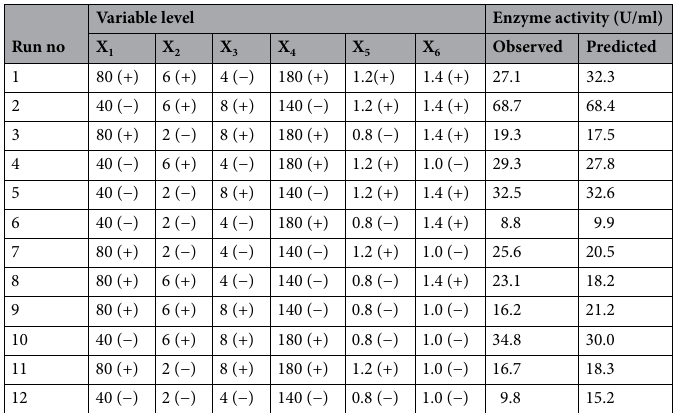
Table 2. Plackett–Burman design matrix for screening of six medium components for xylanase production by the Trichoderma harzianum strain. X 1 : Incubation temperature. X2: Incubation time. X 3 : pH. X 4 : Agitation. X 5 : Wheat bran. X 6 : Ammonium sulphate.